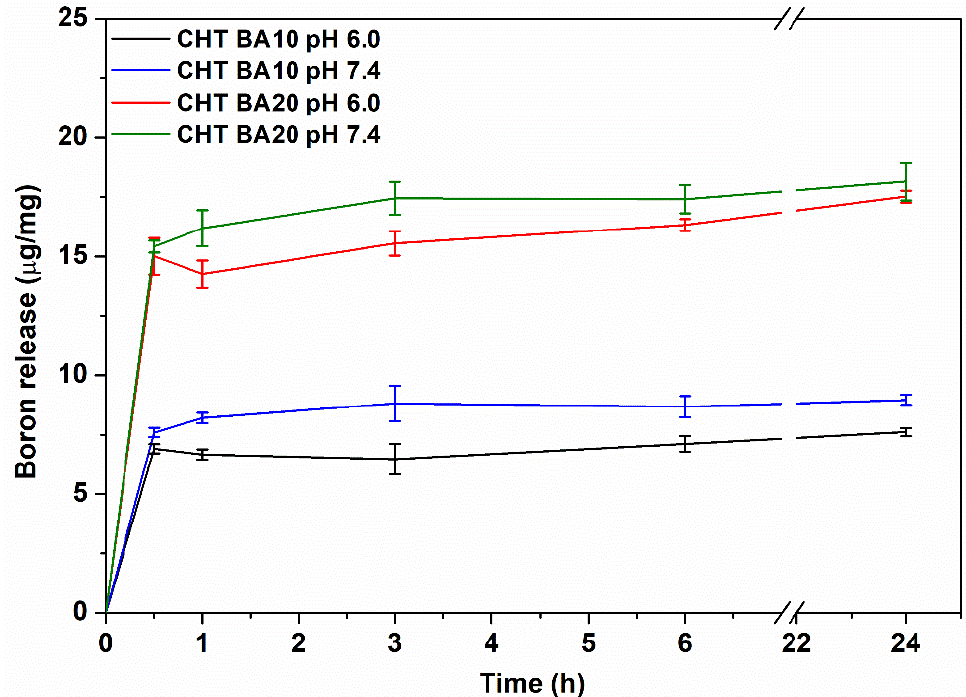
Figure 2. Boron release in PB (pH 6.0) and PBS solution (pH 7.4) at 37 °C.